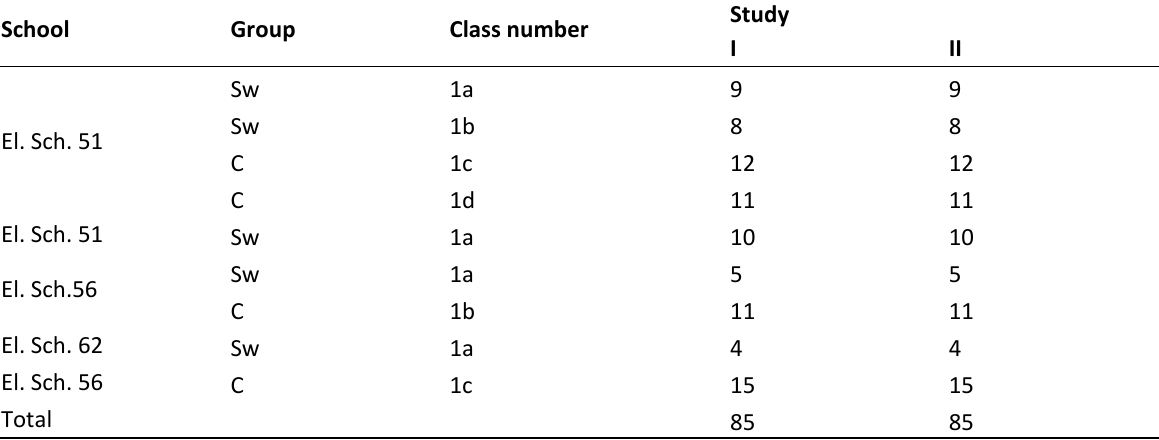
Table 1. Number of girls in Swimmers and Control groups during examinations School